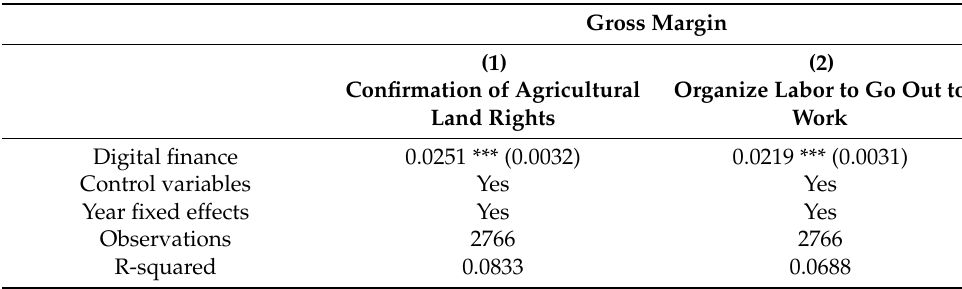
Table 5. Robustness tests by adding